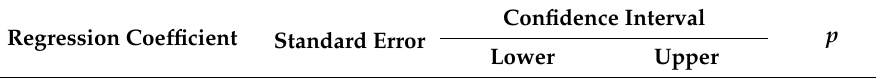
Table 3. Regression analysis with the clinical attachment level (CAL) gain (mm), probing